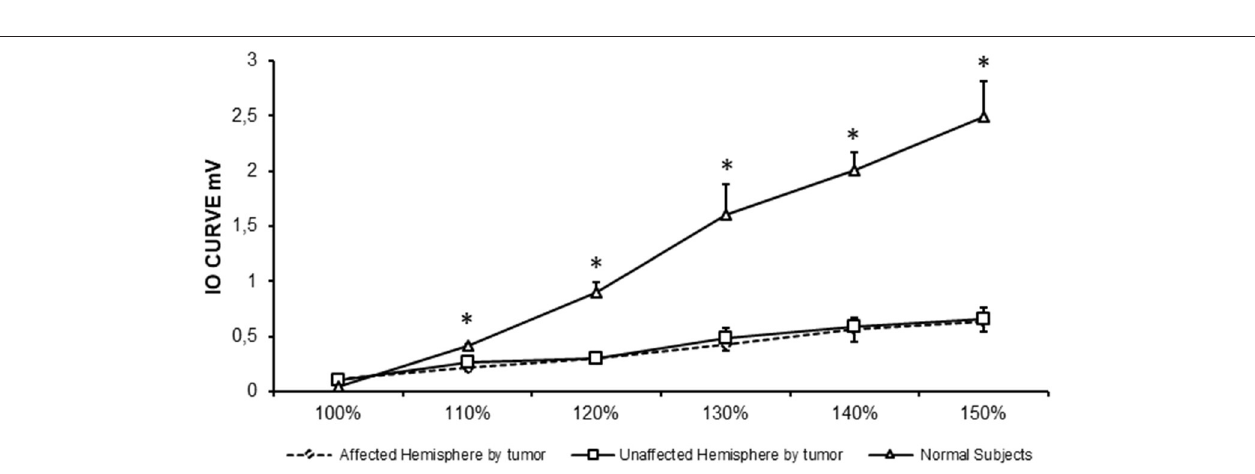
FIGURE 2 | RC in controls and patients with brain tumors (affected and unaffected hemispheres). Stimulus intensities ranging from 100 to 150% RMT (in steps of 10%). * p <